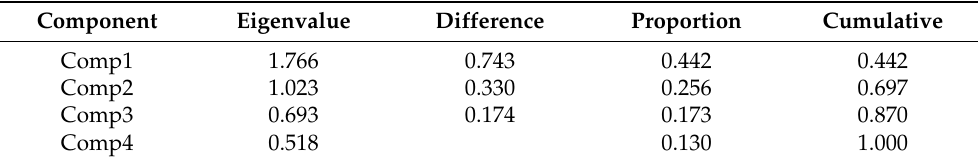
Table A1. PCA estimation for energy security.